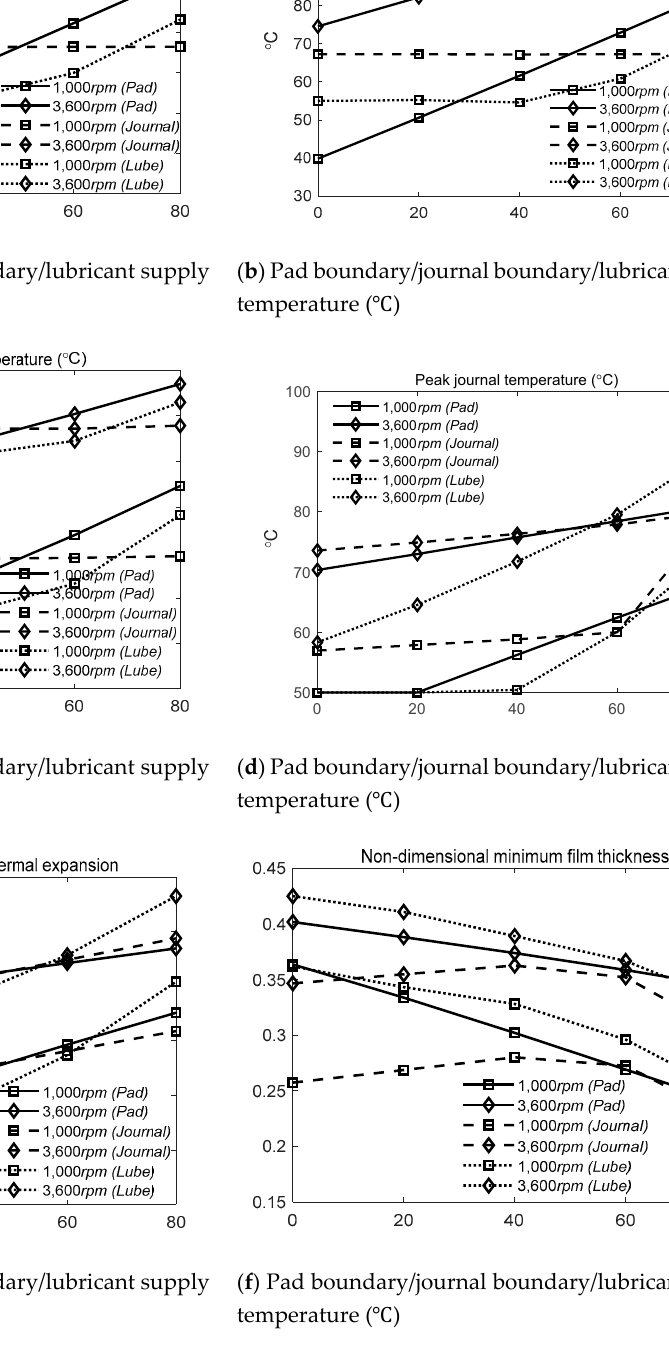
Figure 11. Bearing thermal characteristics: ( a ) 75% bearing pad temperature; ( b ) peak bearing pad temperature; ( c ) peak lubricant temperature; ( d ) peak journal temperature; ( e ) non-dimensional journal thermal expansion; ( f ) non-dimensional minimum film thickness.